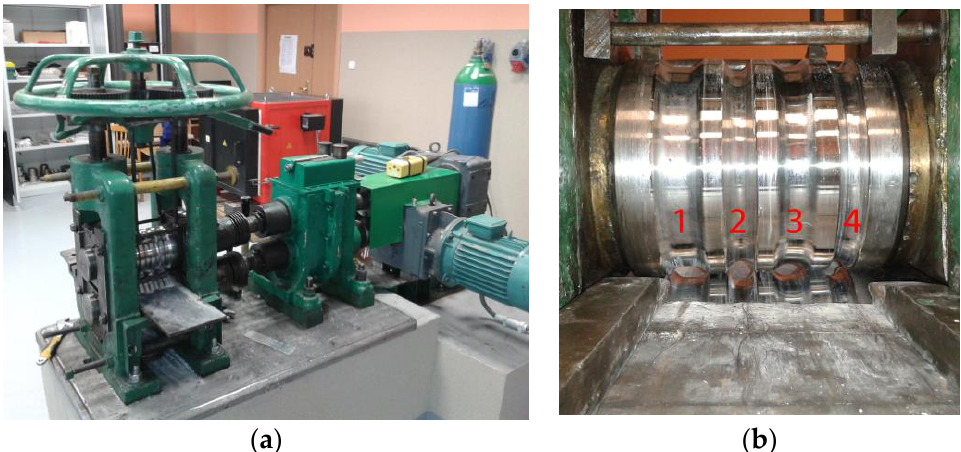
Figure 4. Laboratory rolling mill D150 mm, general view ( a ); arrangement of the grooves along the width of the roll ( b ).